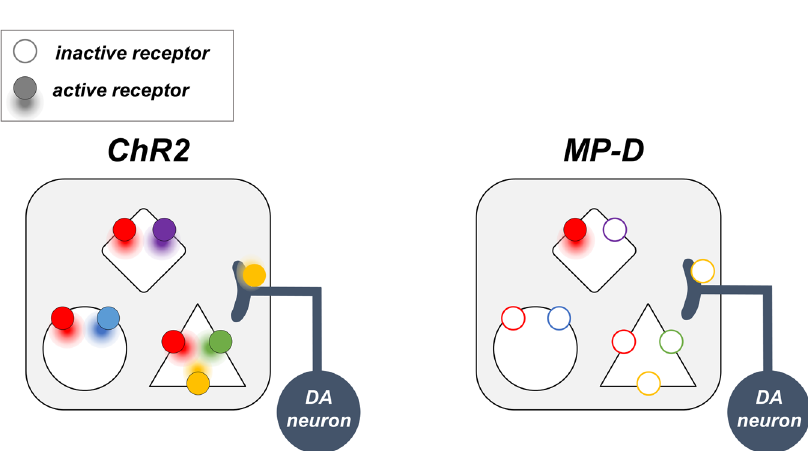
Fig. 3e were normalized to baseline movement and replotted. There was no signi fi cant difference between groups. RM two-way ANOVA. p = 0.99. n = 8 for ChR2 and n = 7 for MP-D1 ago . I Summary of the relative difference in movement initiation, bout duration, and maximum bout velocity for mice with ChR2 or MP-D1 ago in their active and inactive states. ChR2 data from Supplementary Fig. 18d – f and MP-D1 ago data from Fig. 4d – f were normalized to baseline and replotted. Error bars indicate S.E.M.